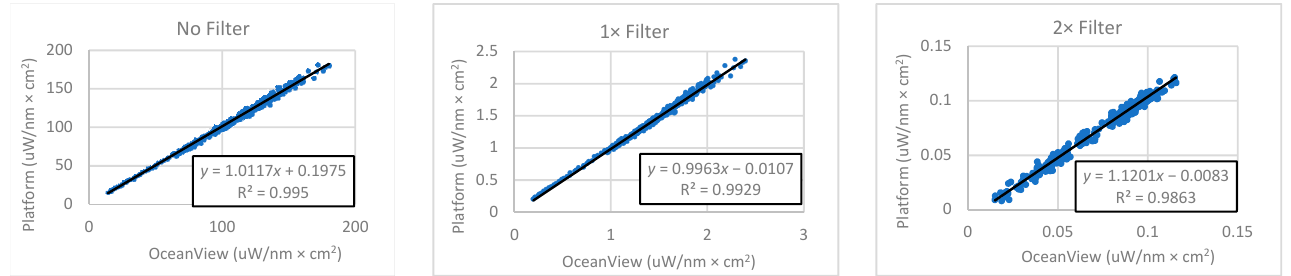
Figure 4. Scatterplots of measurements taken during OceanView control on the x -axis and platform control on the y -axis, both in units of µW/nm × cm 2 , for the three cycles. The plots also show the linear regression line, equation, and correlation coefficient.